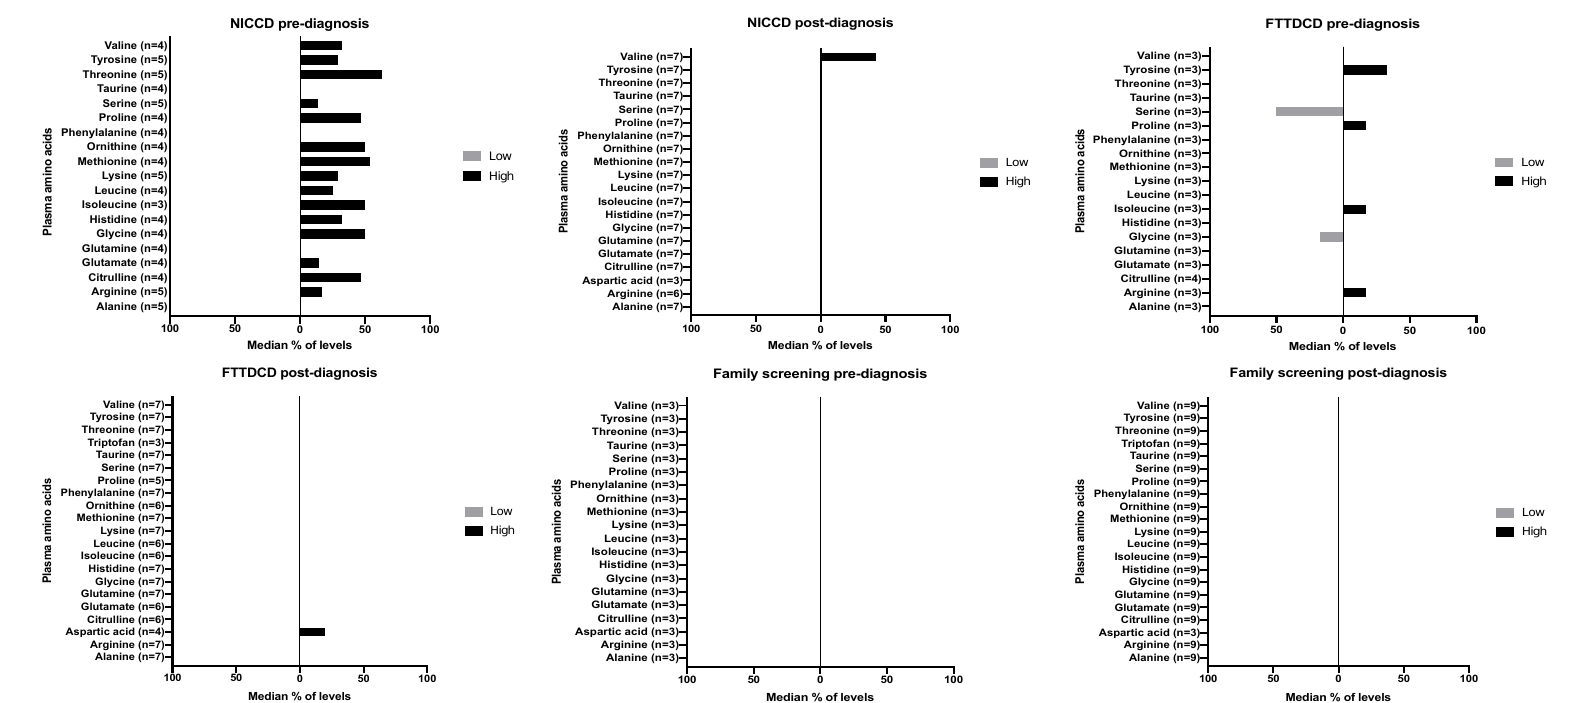
Figure 2. Median % of levels > and < reference range for plasma amino acids levels pre- and post-diagnosis. Abbreviations: NICCD—neonatal intrahepatic cholestasis; FTTDCD—failure to thrive and dyslipidemia caused by citrin deficiency; N—number of patients with each biochemical measure. A minimum of three patients results were included for amino acids. Normal reference ranges were specific for each laboratory and patient’s age.